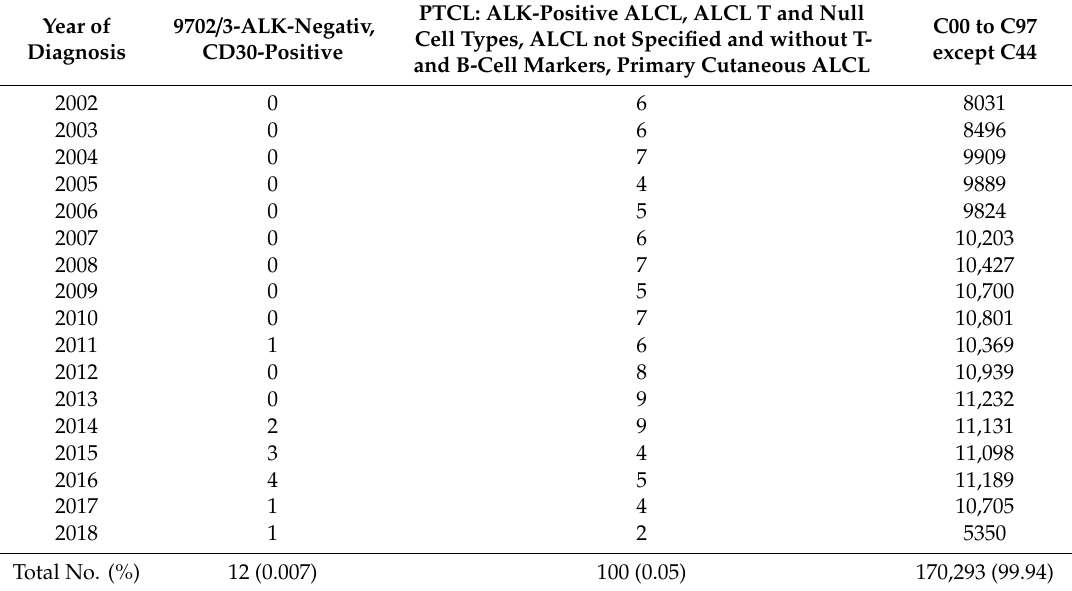
Table 1. Annual numbers of ALK-negative and CD-30 positive anaplastic large cell lymphomas (ALCL) in comparison to peripheral T-cell-lymphomas (PTCL) and all other malignancies except for non-melanocytic skin